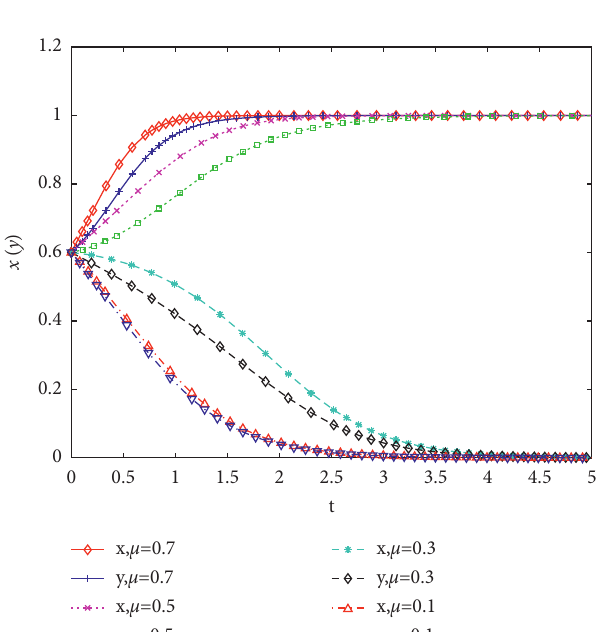
Figure 8: X and initial value point.